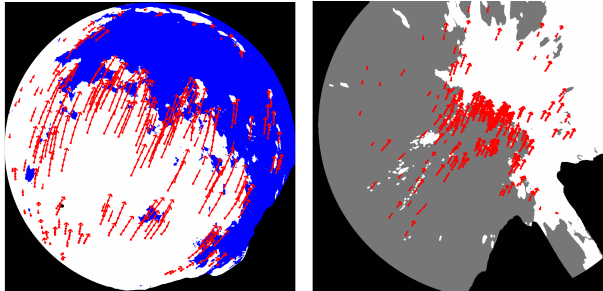
Figure 5. Example of cloud motion analysis with the optical flow technique. Left: cloud motion vectors (CMVs) drawn in the binary cloud image (clouds in white). Right: CMVs transformed to the cor- responding shadow map (shadows in grey) on the regular grid. The number of detected vectors is reduced for this visualization.